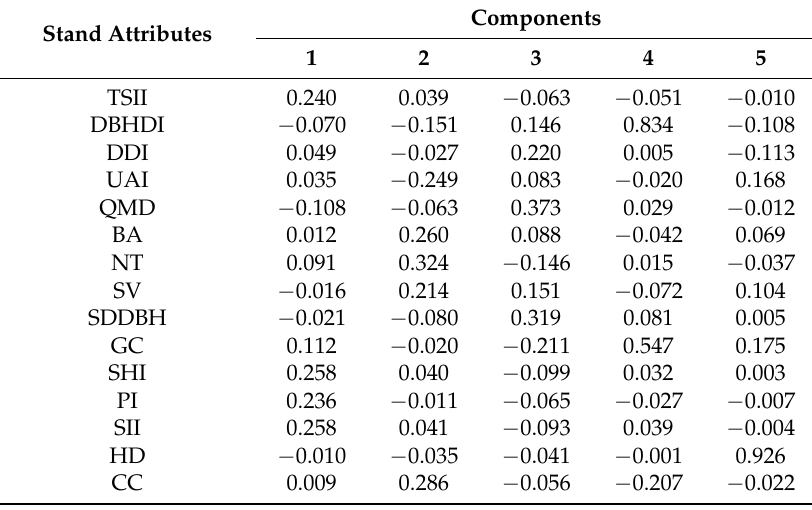
Table 5. Component score coefficient matrix generated by factor analysis.